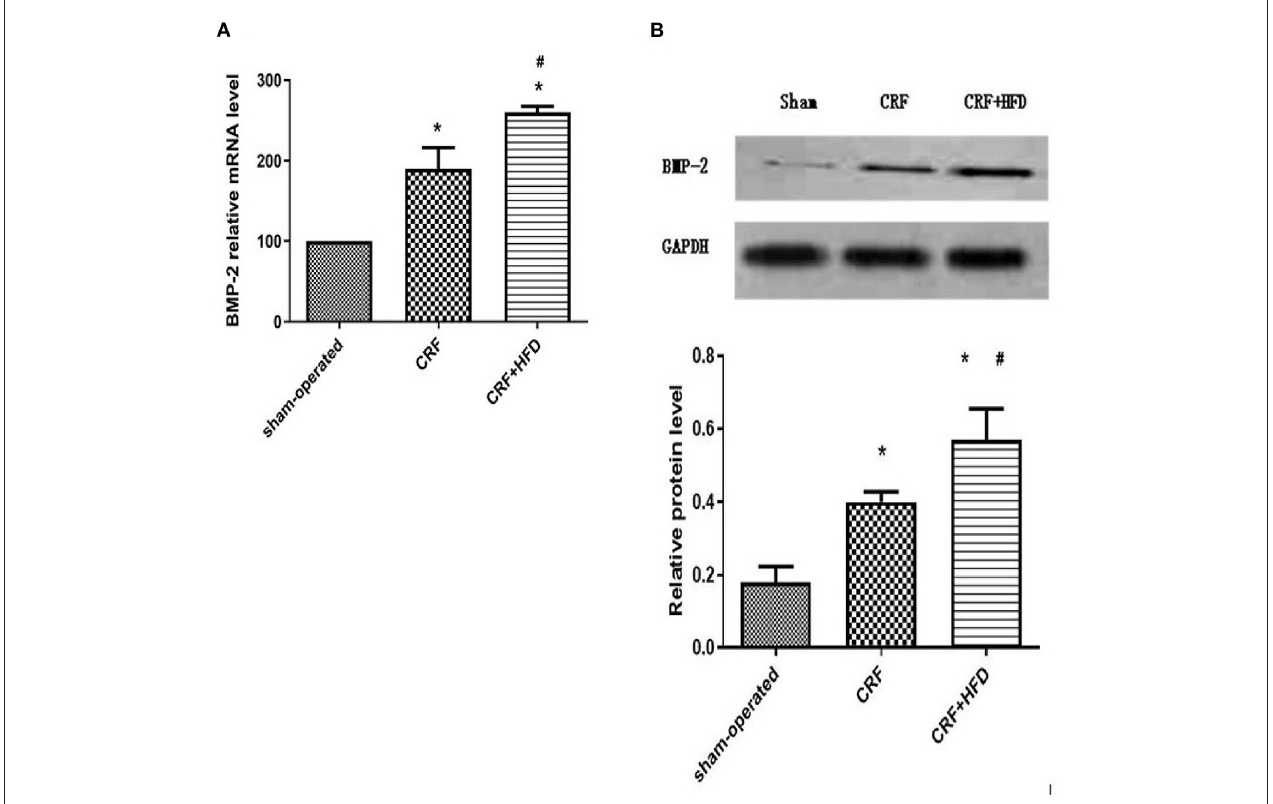
FIGURE 4 | Comparison of BMP-2 mRNA (A) and protein (B) expression in the aortas of rats in each group. Six rats were included in each group. * P < 0.05 vs. sham-operated group; # P < 0.05 vs. CRF group. BMP-2, bone morphogenetic protein-2; CRF, chronic renal failure; HFD, high fat diet.